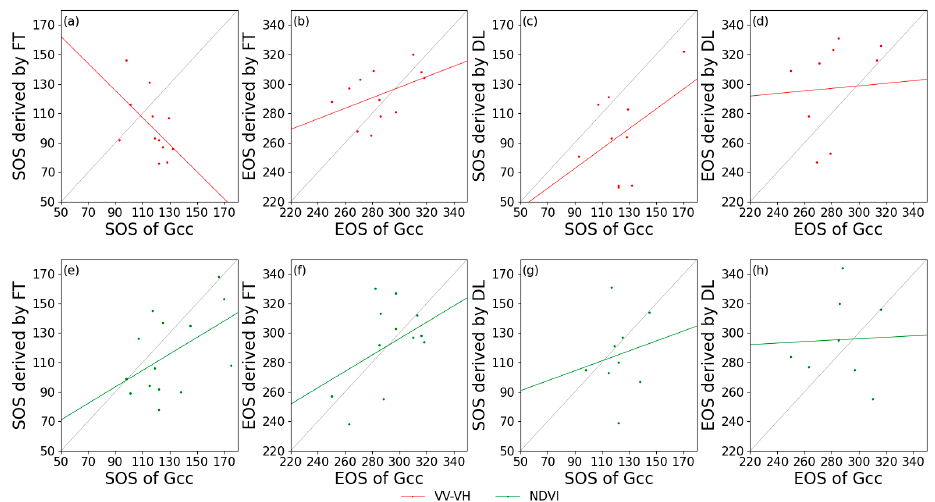
Figure 7. Correlations of phenological metrics in day of year between PhenoCam (x-axis) and satel- lite remote sensing (y-axis) in deciduous forests. ( a , e ): SOS extracted by FT; ( b , f ): EOS extracted by FT; ( c , g ): SOS extracted by DL; and ( d , h ): EOS extracted by DL. Black lines: VH/VV; red lines: VV- VH; and green lines: NDVI.